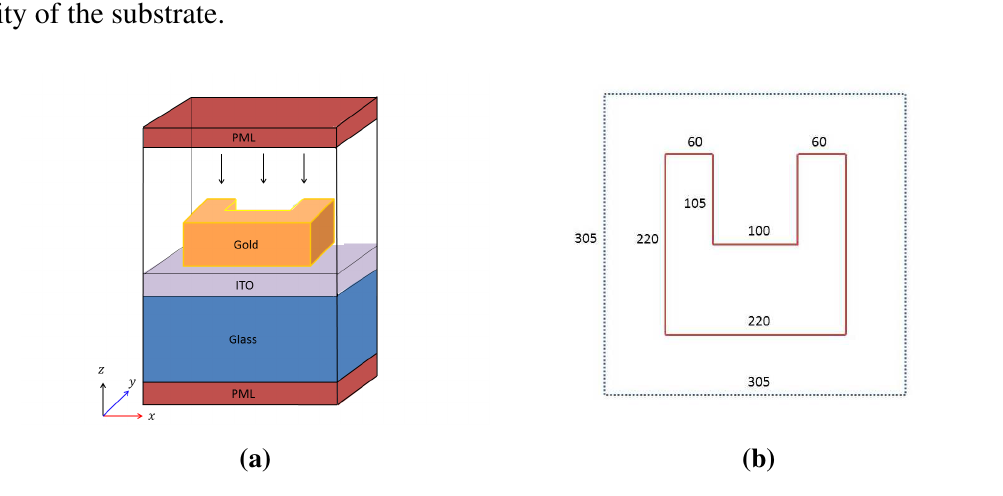
( a ) The computational domain for optical pulse propagation through three dimensional gold nanostructures; ( b ) x − y cross-section of the U -shaped gold nanostructure with the unit of nm